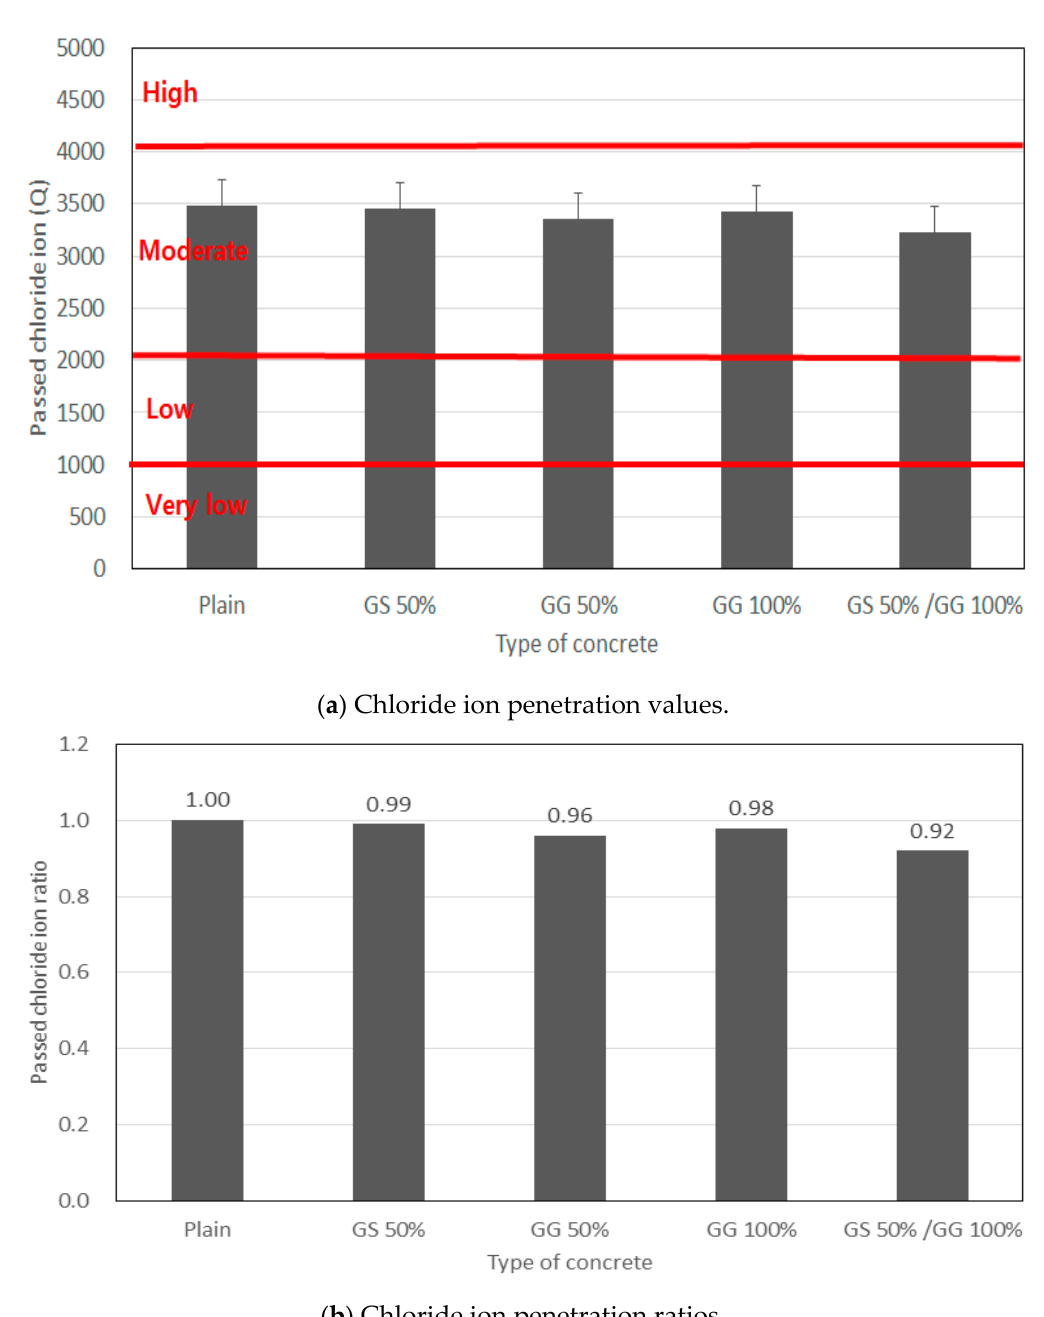
Figure 7. Test results for chloride ion penetration.